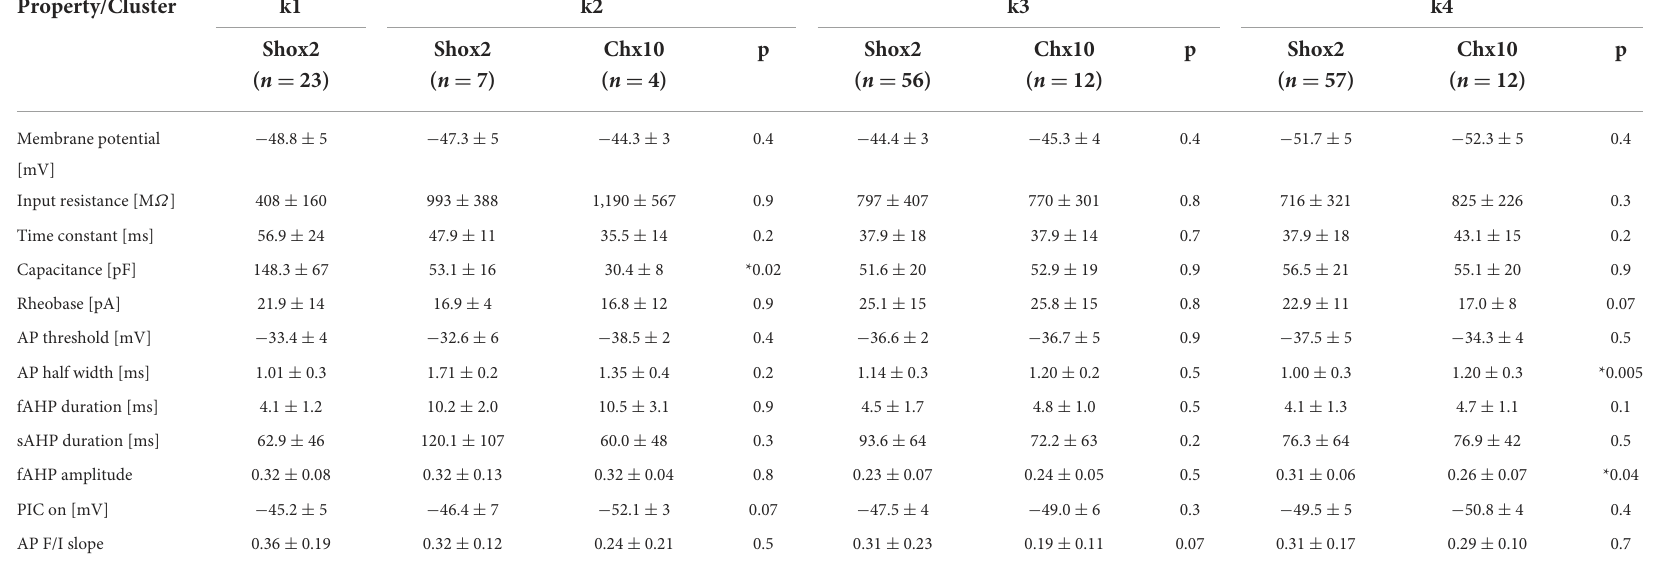
TABLE 2 Comparison of properties of Shox2 and Chx10 neurons in each k